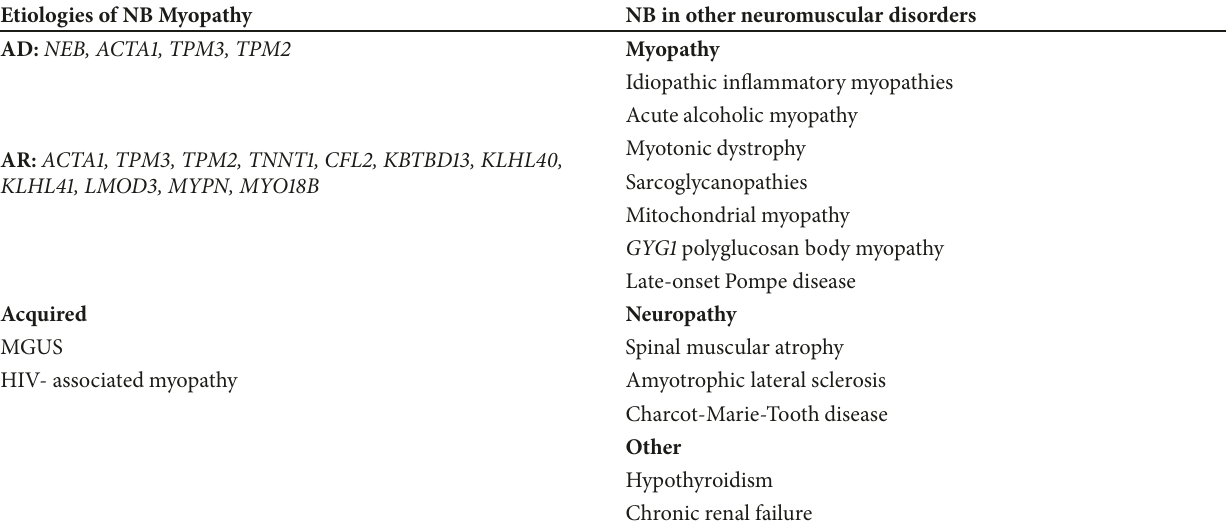
Table 1: Genetic and acquired etiologies of NB